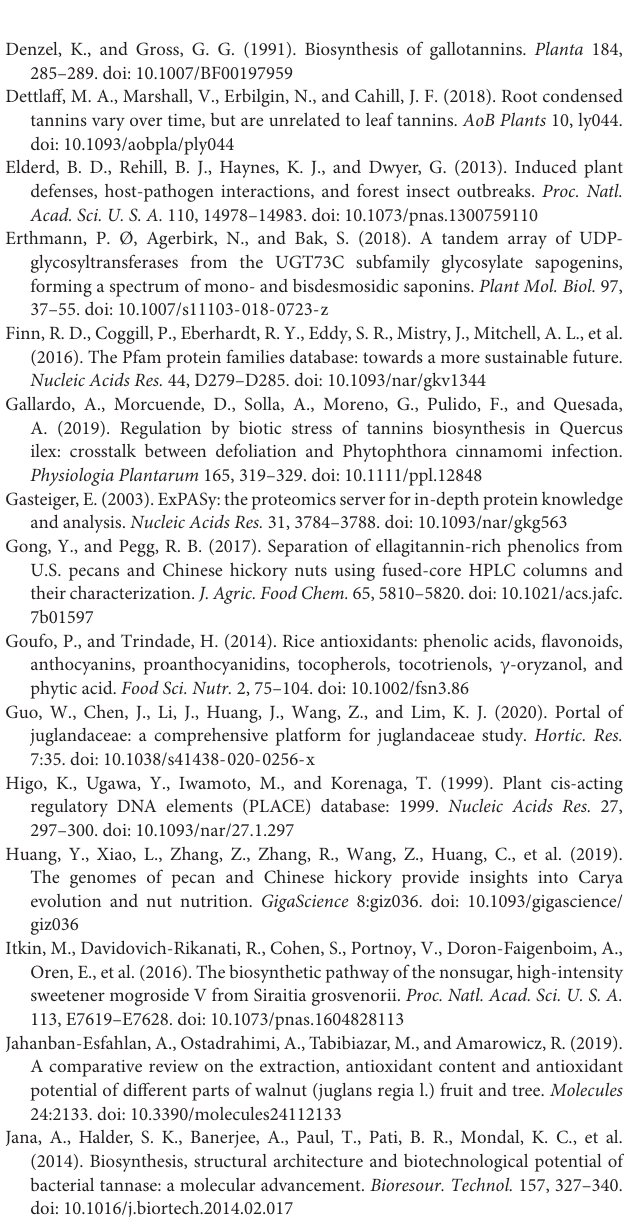
Supplementary Table 1 | Summary of TA genes and other carboxylesterases. Supplementary Table 2 | Detailed information of plant TA and TA-like proteins. Supplementary Table 3 | Summary of conserved domain in TA and TA-like proteins in Juglandaceae. Supplementary Table 4 | Potential miRNAs and target TA genes in Juglandaceae. Supplementary Table 5 | The list of primers sequence used for RT-qPCR. Supplementary Table 6 | Scaffold location of TA and TA-like genes in